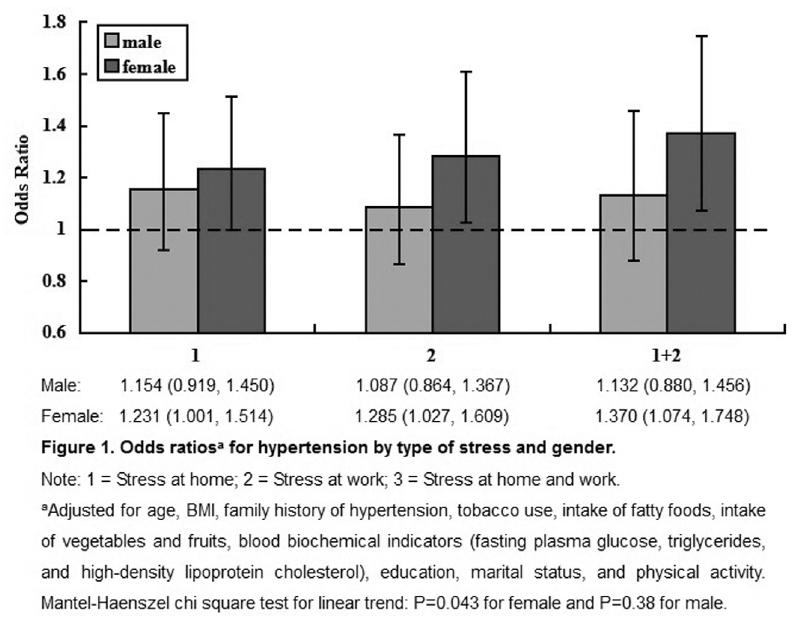
Fig 1. Odds ratios of hypertension by types of stress and gender. This figure shows the interaction of gender and different types of stress on the risk of hypertension. Among women with stress at work and at home simultaneously, the odds of hypertension (OR = 1.370, 95% CI [1.074, 1.748]) concomitantly increased with change of stress type (P = 0.043 for linear trend). This trend was not significant for men (P =